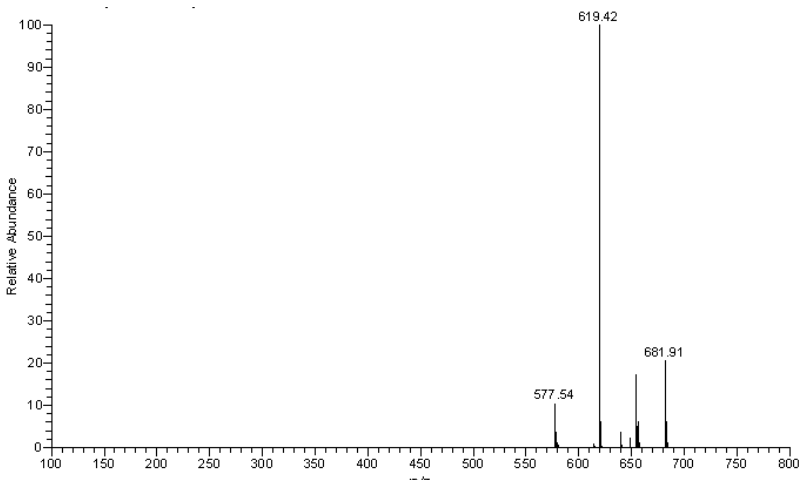
Figure 3. ESI-MS of camellianin A.